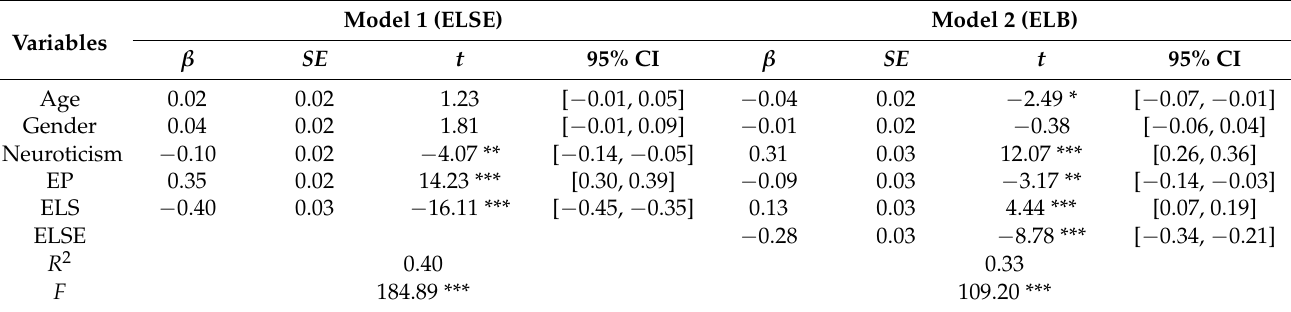
Table 2. Testing for the mediation effect of English learning